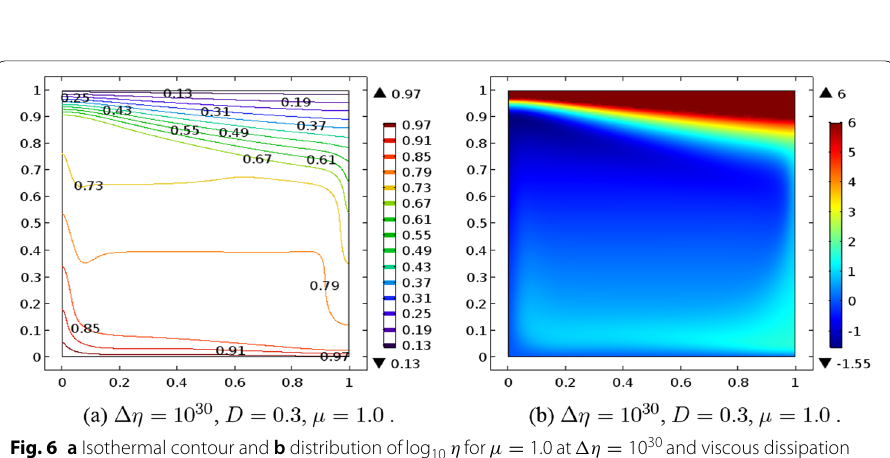
Fig. 6 a Isothermal contour and b distribution of log 10 η for µ = 1.0 at �η = 10 30 and viscous dissipation = 0.1 and Ra = 10 D = 0.3 with θ 0